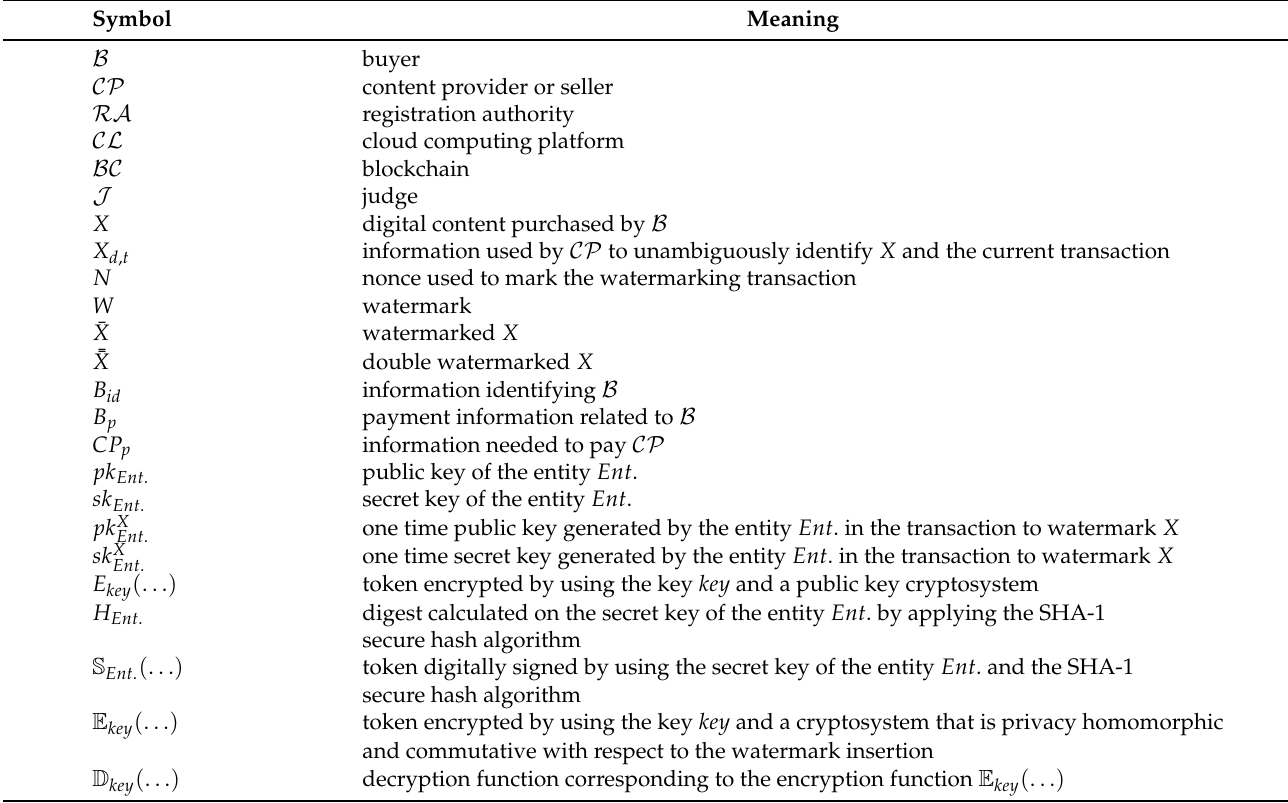
Table 1. The symbols used to describe the proposed protocol.